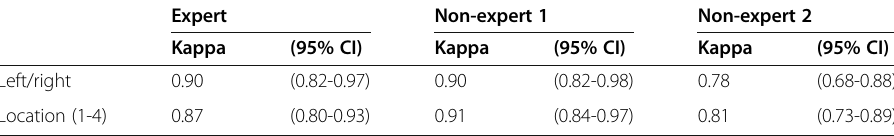
Table 3 Kappa values for intra-observer agreement